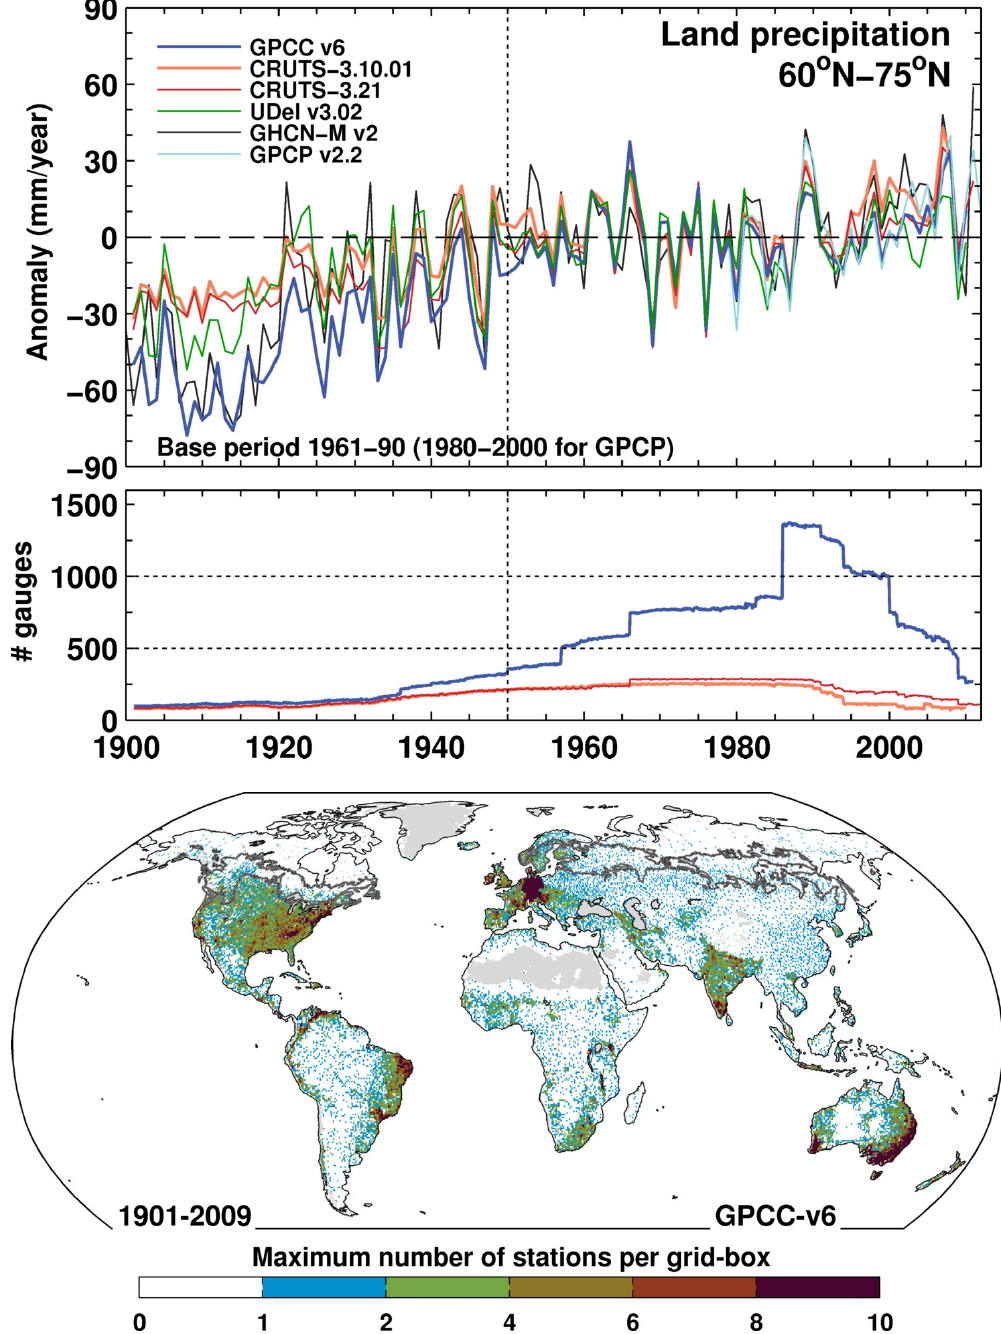
Figure A2. Annual land precipitation anomalies in the Arctic region as represented by different datasets along with their associated temporal and spatial gauge coverage since 1900. The datasets used are: Global Precipitation Climatology Centre (GPCC v6), Climatic Research Unit (CRU TS–3.10.01 and CRU TS–3.21), University of Delaware (UDel v3.02), Global Historical Climatology Network-Monthly (GHCN–M v2) and Global Precipitation Climatology Project (GPCP v2.2). The vertical dotted lines indicate the start of the period of analysis used in this study. The boreal forests are outlined in gray on the